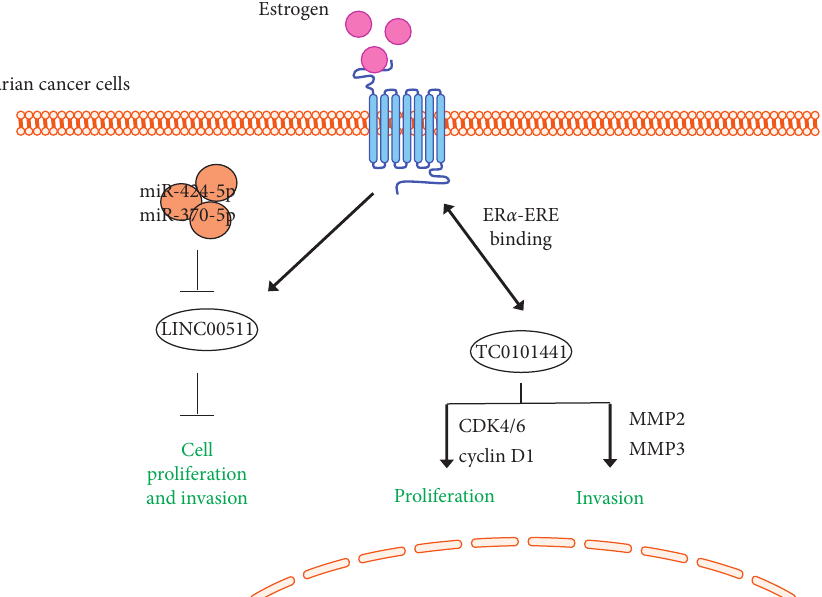
Figure 2: The interaction of lncRNAs and estrogen in ovarian cancer. Two lncRNAs, LINC00511 and TC0101441, have been reported to interact with estrogen and its receptor in ovarian cancer. Solid arrow: induction; flat-ended arrow: